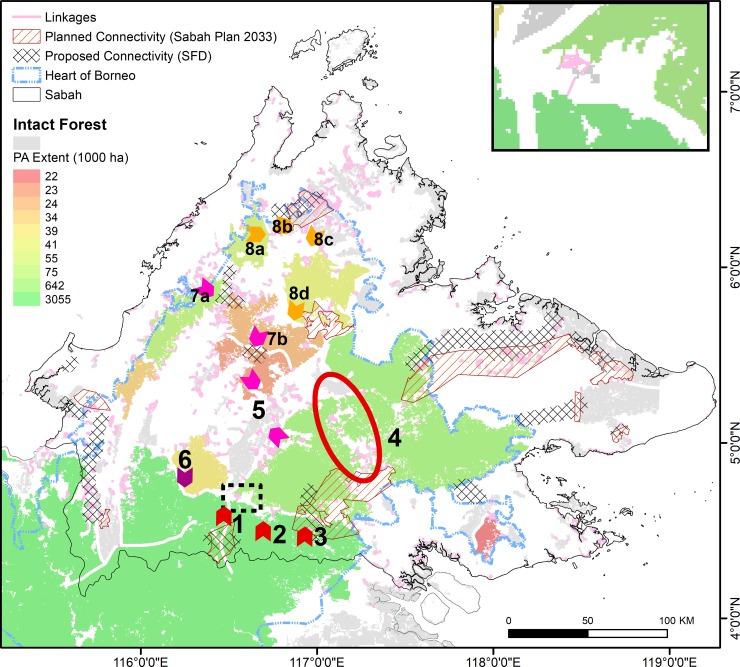
Select inter-patch links (numbered) by which forest corridors/underpasses would enhance the integrity of the northern Heart of Borneo region following planned road developments in Sabah.Note: Numbered arrows are indicative sites for corridor and road-underpass development that would enhance post-development forest/PA connectivity across Sabah and the northern HoB (S1 Table). The circled area at Site 4 is important for regional connectivity but would not require corridors/underpasses, just sound management alone (S1 Table). ‘Planned connectivity’ zones were adopted by the Sabah Structure Plan 2033 Proposal Map endorsed by Sabahan government in 2016 (plan SSP2033 Gazette LXXI/47/231) [36]. Planned connectivity zones near site 1 and in south-western Sabah approximate those of the Heart of Borneo Corridor Implementation Project [25, 54]. ‘Proposed connectivity’ zones are according to an earlier Sabah Forestry Department (SFD) proposal endorsed by the Sabah Structure Plan 2033 report [29]. PA extent is shown for the ten post-development intact forest patches with greatest PA extents. Intact forest patches are as defined previously. A corridor at Site 5 would bridge a series of disjointed patches lacking PAs (grey).